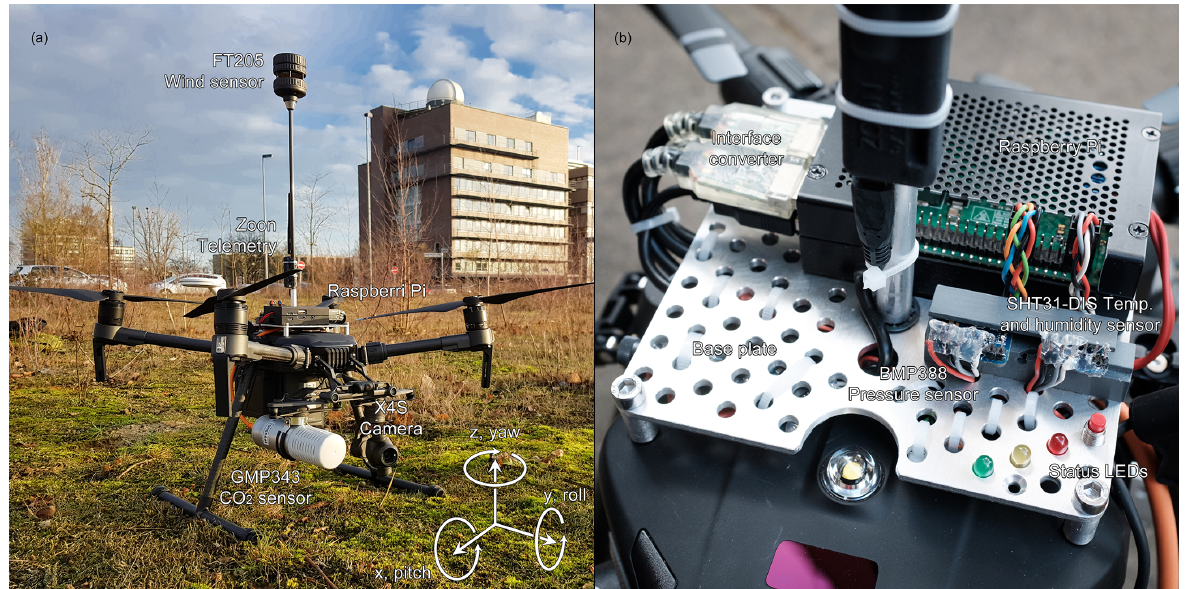
Figure 1. UAV and instrumentation. (a) Overview including UAV coordinate system as defined by us. (b) Zoom on base plate.